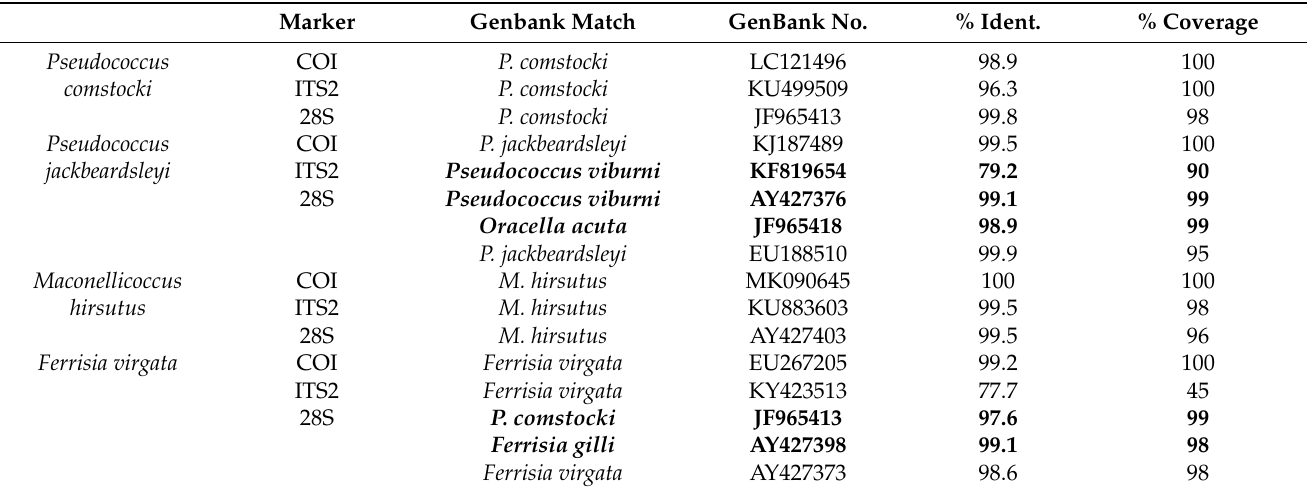
Table 3. BLASTn results for COI, ITS2, and 28S sequences obtained in this study. Species determinations were made based on the best matches obtained with COI sequences. The results shown are from one representative of each species. Bold font denotes incorrect organisms among top matches (adapted from Puig et al. [24]).